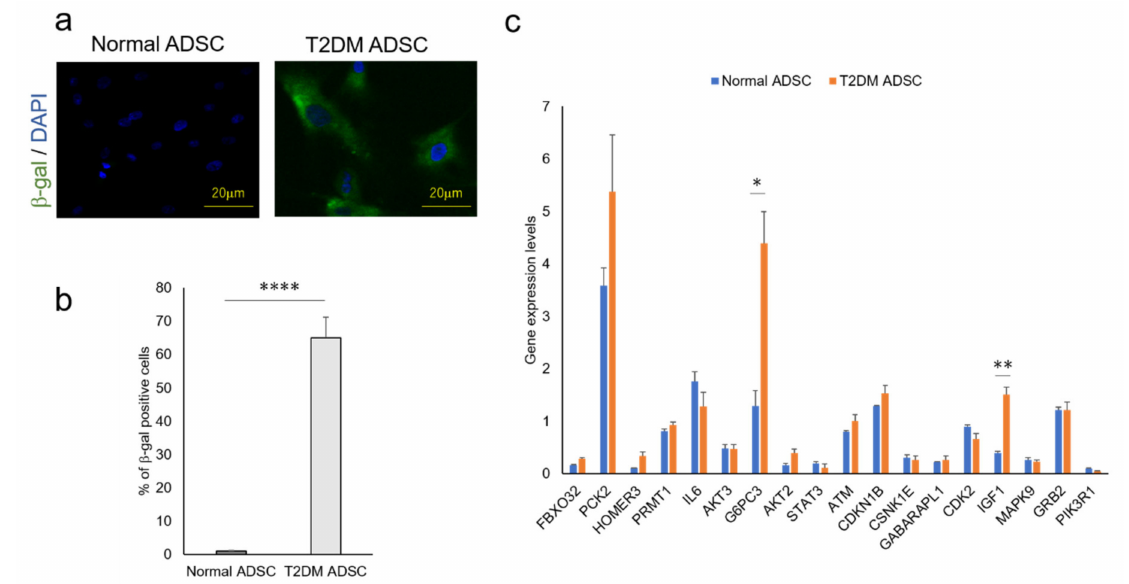
Figure 4. Quantitative analysis of cell aging of ADSCs derived from patients with type II diabetes mellitus and the genes related to the FoxO signaling pathway. The difference in cell aging between the normal and T2DM ADSCs and the expression levels of the genes related to the FoxO signaling pathway were quantified. ( a ) The images of aged cells labeled with green fluorescent dye using a cell aging marker, β -gal, are shown. The aging marker-positive cells were counted. ( b ) The positive cell rates in terms of mean ± SE are shown. The number of samples was n = 3. The percentage of β -gal positive cells was evaluated three times independently. The unpaired t -test was used to test for statistical significance. **** p value < 0.0001. ( c ) The genes related to the FoxO signaling pathway in normal and T2DM ADSCs were quantified using quantitative PCR. The quantified genes in terms of mean ± SE. The number of samples was n = 3. The gene expression level was evaluated three times independently. The unpaired t -test was used to test for statistical significance. For G6PC3 , * p = 0.0196. For IGF1 , ** p =